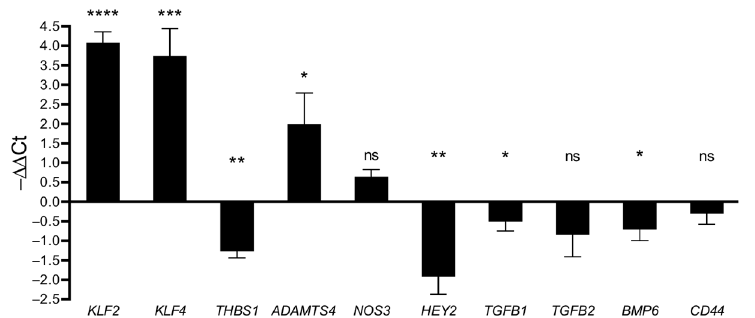
Figure 4. RT-qPCR analyses of selected transcripts in CCM1 − / − ECs compared to CCM1 +/+ ECs ( n = 3 per genotype). For statistical analyses, student’s two-tailed t tests were used: * p < 0.05, ** p < 0.01, *** p < 0.001, **** p < 0.0001, ns = not significant.